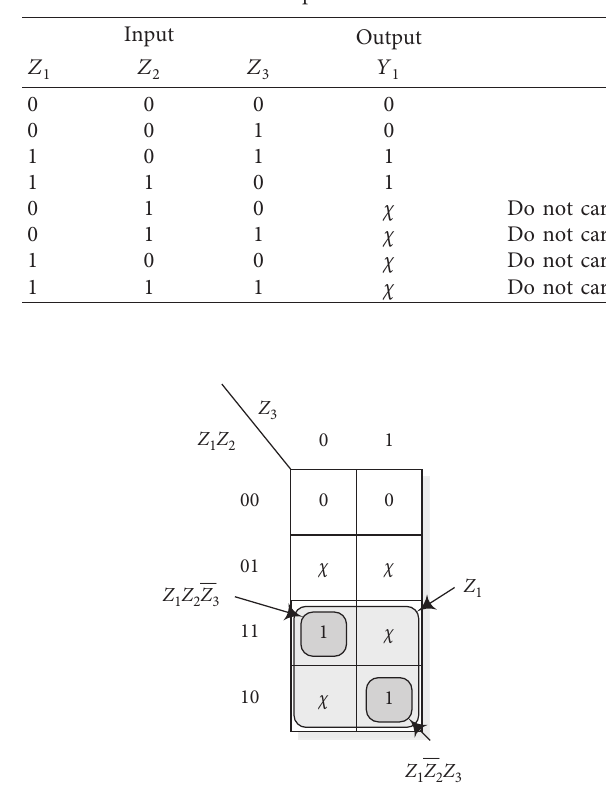
� Z . So you can see the advantage of using 1 1